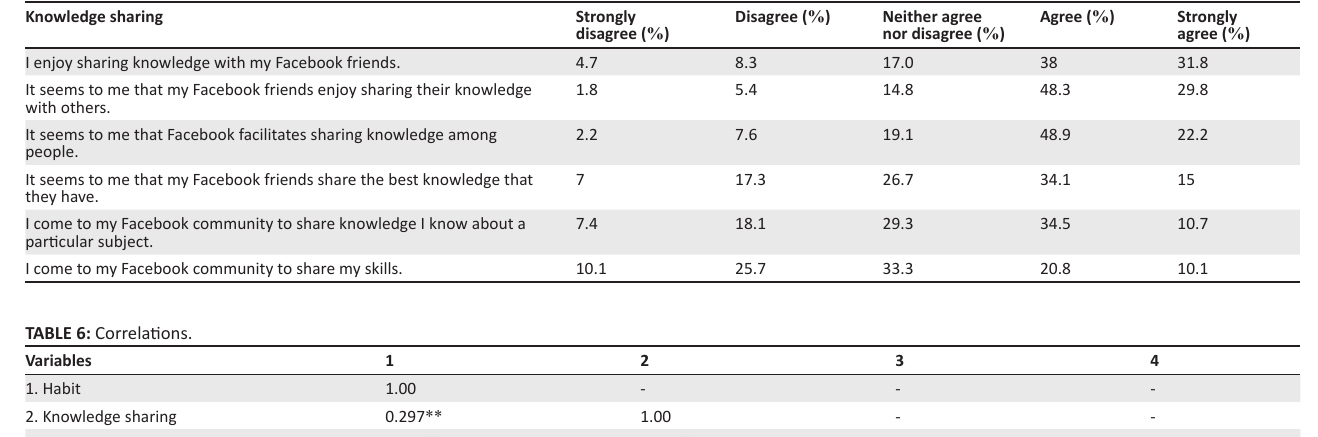
TABLE 5: Knowledge sharing frequencies ( n = 447). Knowledge